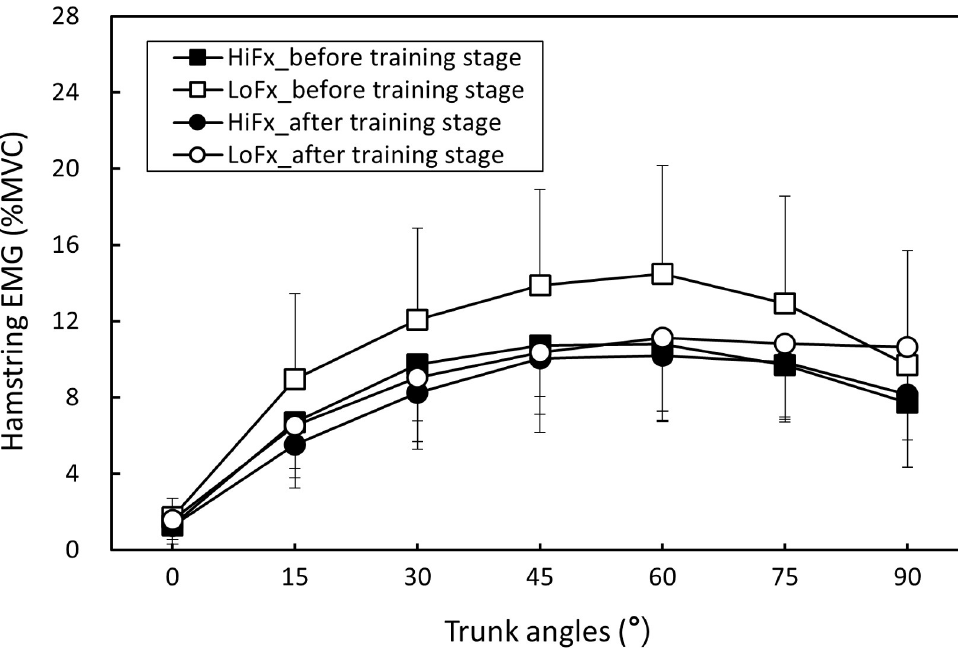
Fig 4. Changes in hamstring activation (mean and standard deviation) in the two participant groups before and after flexibility training stage (HiFx: High flexibility; LoFx: Low flexibility).